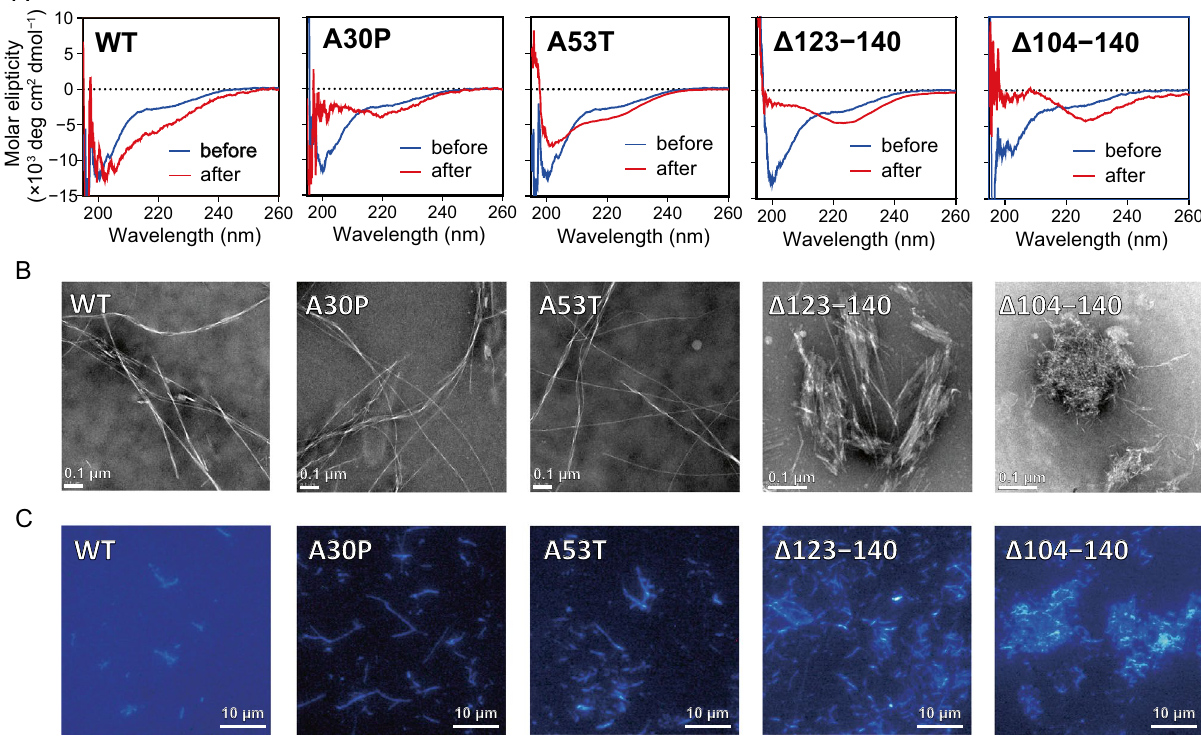
Figure 4. Far-UV CD spectra, TEM and TIRFM images of α-syn variants after 3-day incubation. ( A ) Far-UV CD spectra of α-syn variants before (blue line) and after (red line) the incubation at 37 °C for 3 days. Protein concentration was 20 μM. deg , degrees. ( B ) TEM images of α-syn variants after 3-day incubation. Scale bar represents 0.1 μm. ( C ) TIRFM images of α-syn variants after 3-day incubation. Amyloid fibrils were stained by ThT. Scale bar represents 10 μm.